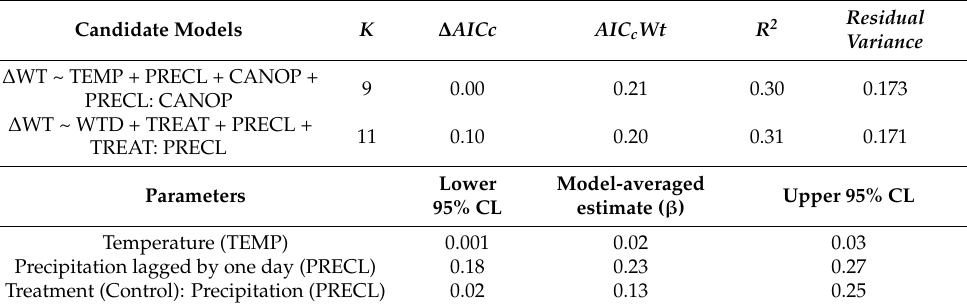
Table 5. Most parsimonious models of silvicultural treatment and stand characteristic explaining daily variation in water table depth ( ∆ WT ) before treatments, including the number of parameters (K), difference in AIC c compared to the highest-ranked model ( ∆ AIC c ), AIC c model weight ( AIC c Wt ), and predictive power (marginal R 2 ). Parameters appearing in the second portion of the table show the variables for which 95% confidence intervals exclude 0 and that influenced the response variable. The count of parameters includes the variance associated with the random-block effect, the treatment within-random-block effect and the residual variance. Note that girdling was the reference level of the treatment variable. Candidate